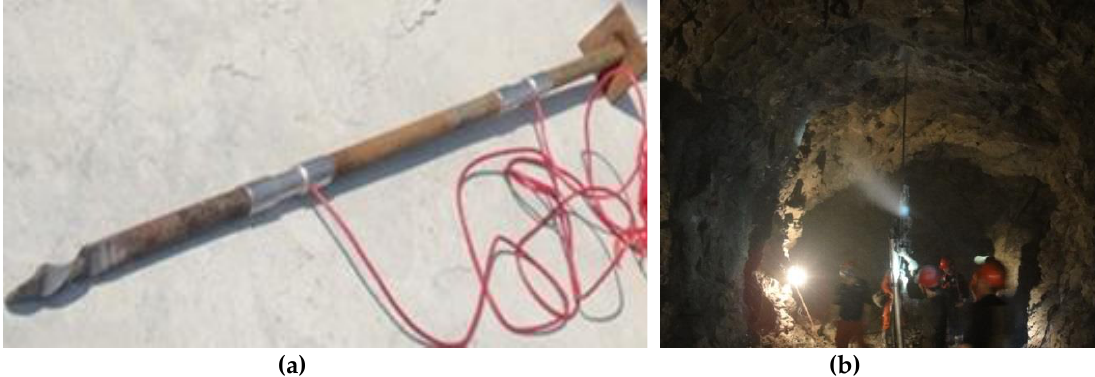
Figure 14. Monitoring of bolt stress. ( a ) Rock-bolt dynamometer and ( b ) arrangement of monitoring points.